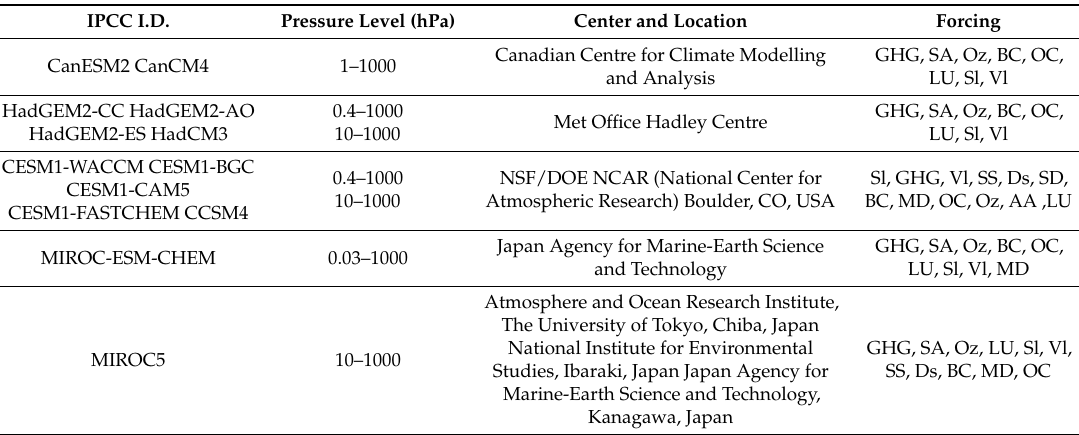
Table 1. The CMIP5/IPCC Data Sets and Selected Information.